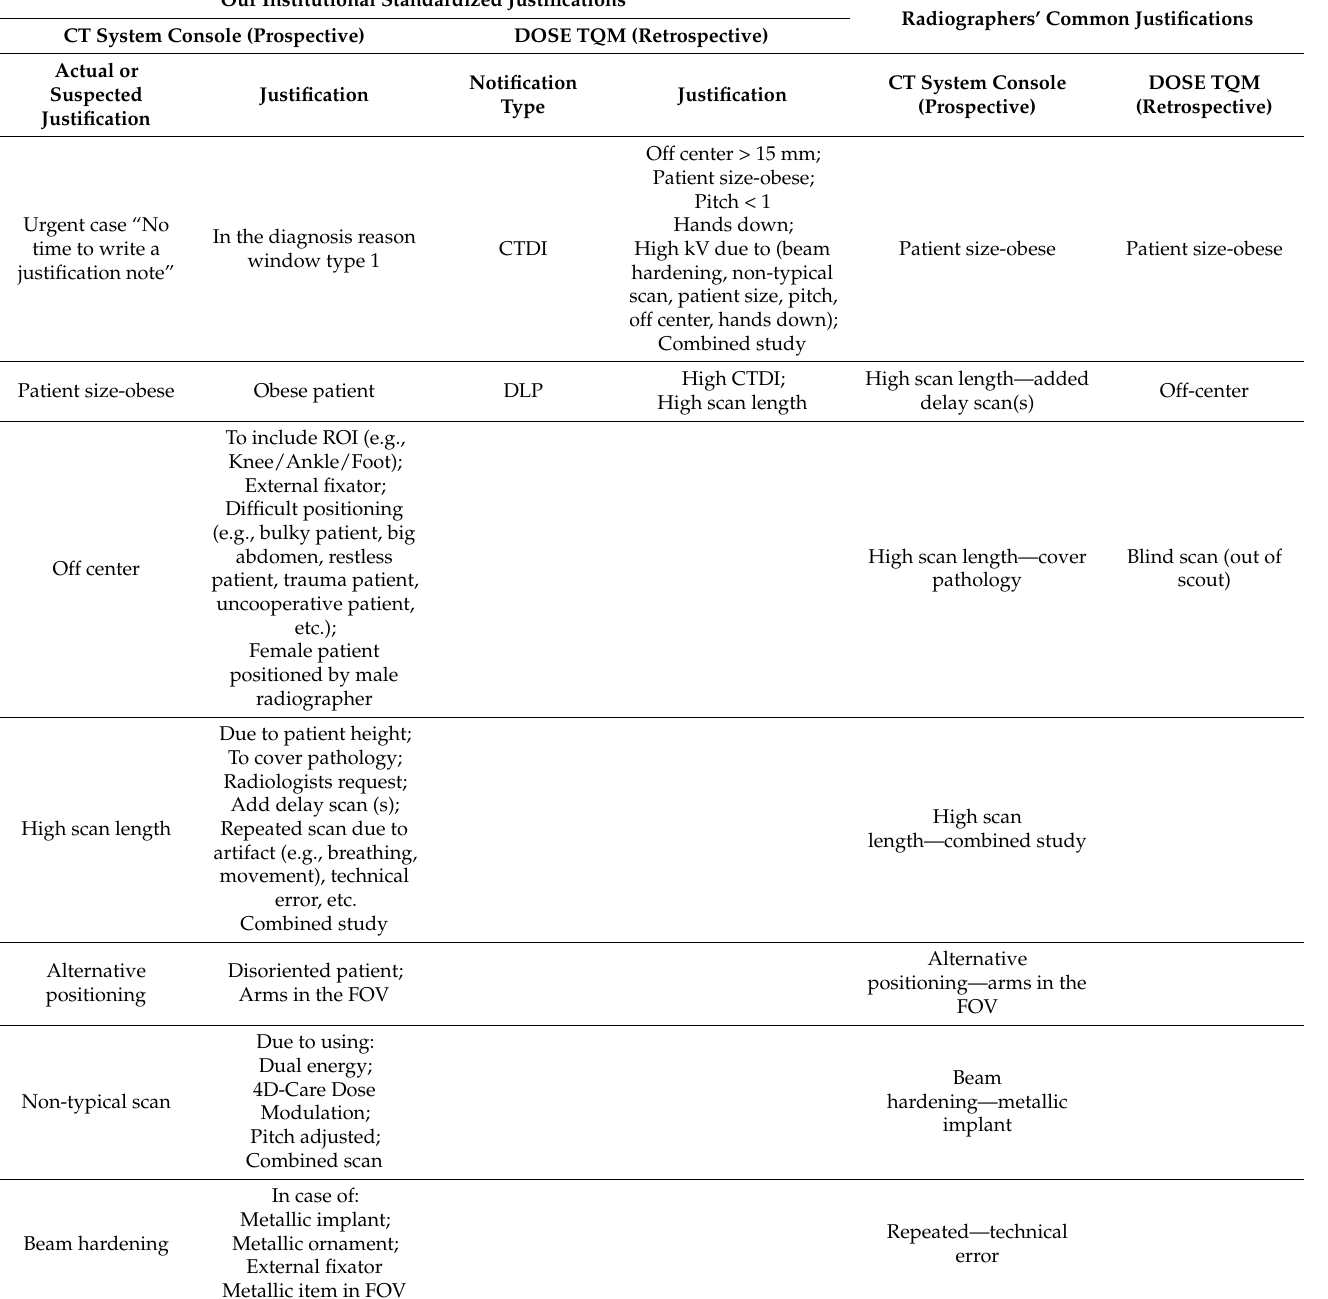
Table 3. Common Justifications used by our CT Radiographers’ using the prospective CT Dose Notification and retrospective DOSE TQM monitoring